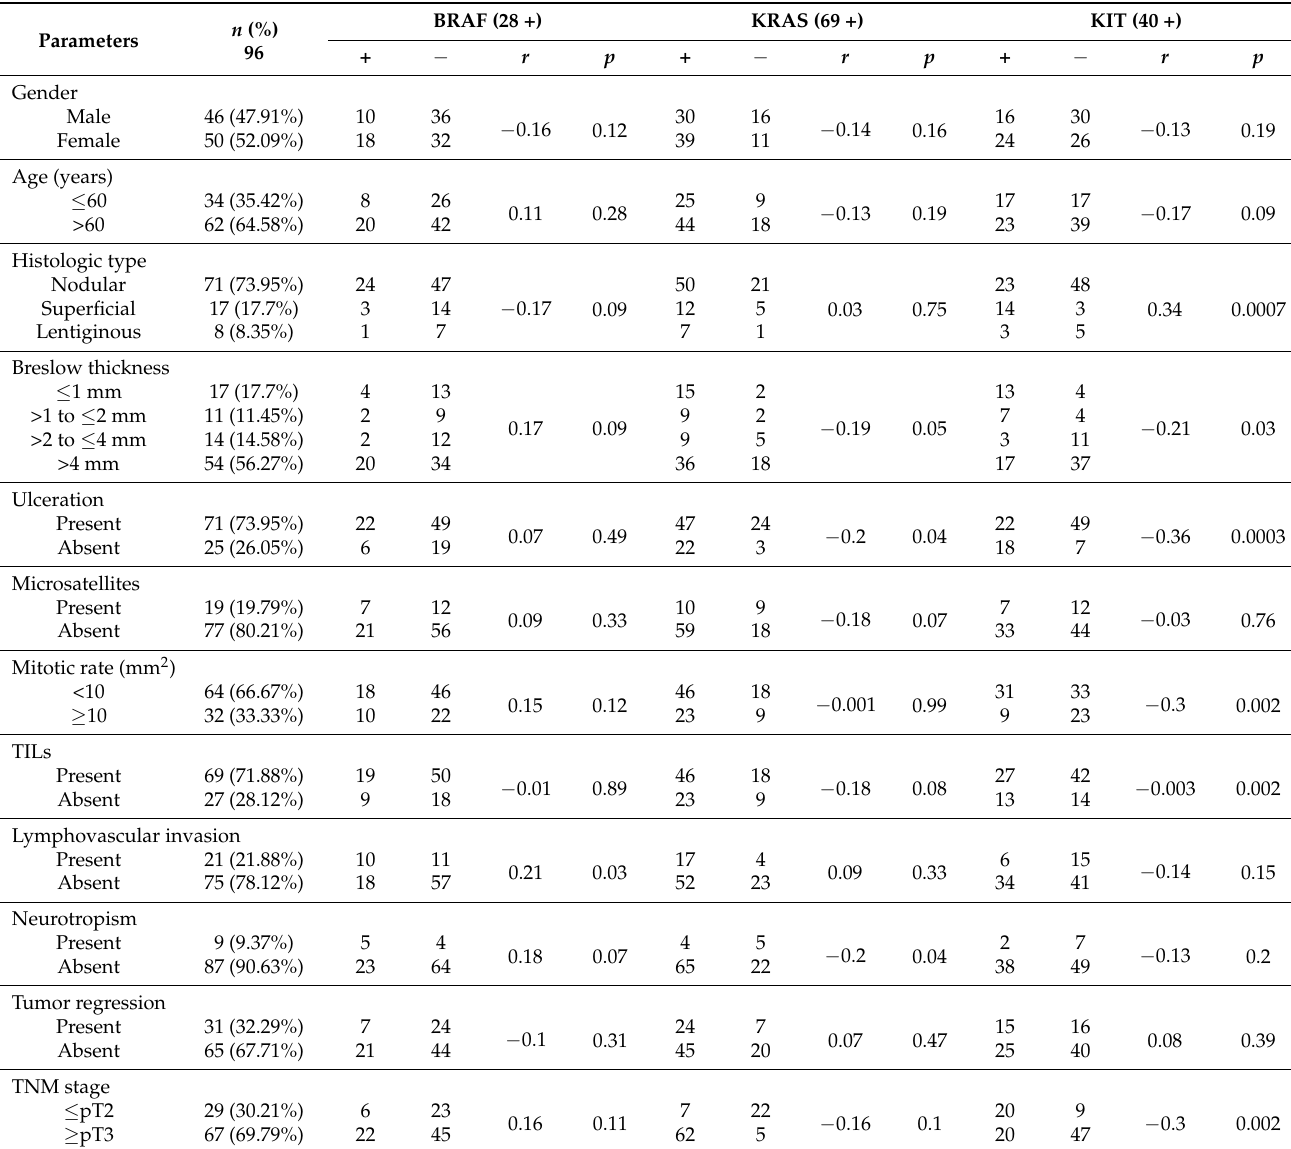
Table 1. Correlations between immunohistochemical expression of BRAF, KRAS, and KIT and clinicopathological parameters (TIL = tumor-infiltrating